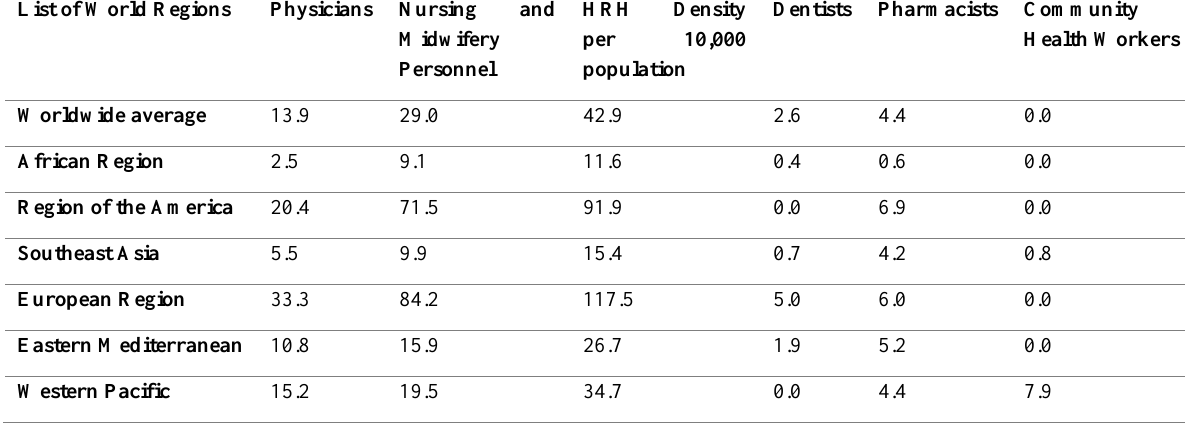
List of World Regions Physicians Nursing and